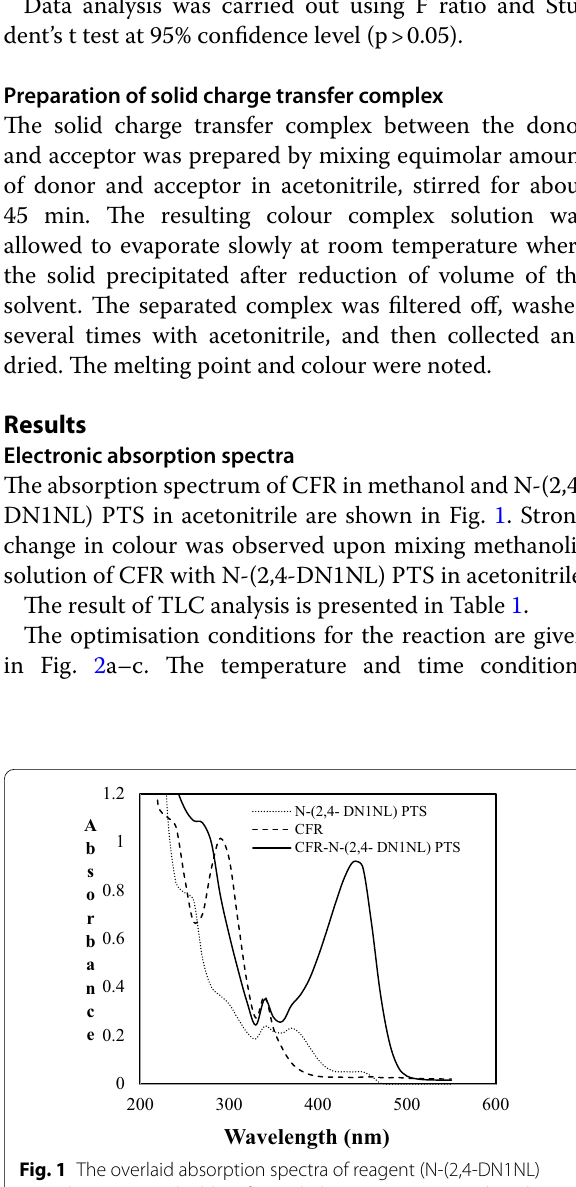
Fig. 2 a Optimisation of reaction temperature for charge transfer formation between CFR and N-(2,4-DN1NL) PTS. b Optimisation of reaction time for charge transfer formation between CFR and N-(2,4-DN1NL) PTS at 30 °C. c Optimisation of the diluting solvent for charge transfer formation between CFR and N-(2,4-DN1NL) PTS